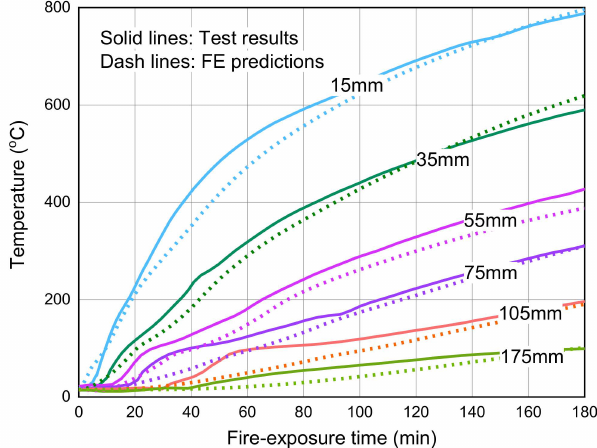
Figure 9. FE predictions versus measured results at various concrete depths.